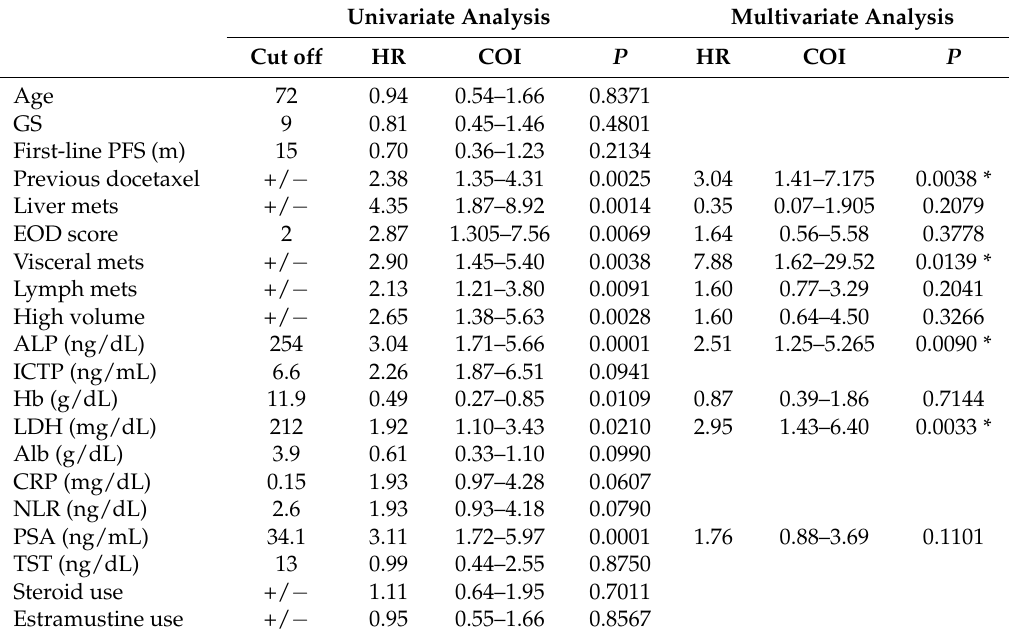
Table 4. Predictive factors of overall survival (OS) in enzalutamide- and abiraterone-treated patients. Univariate Analysis Multivariate Analysis